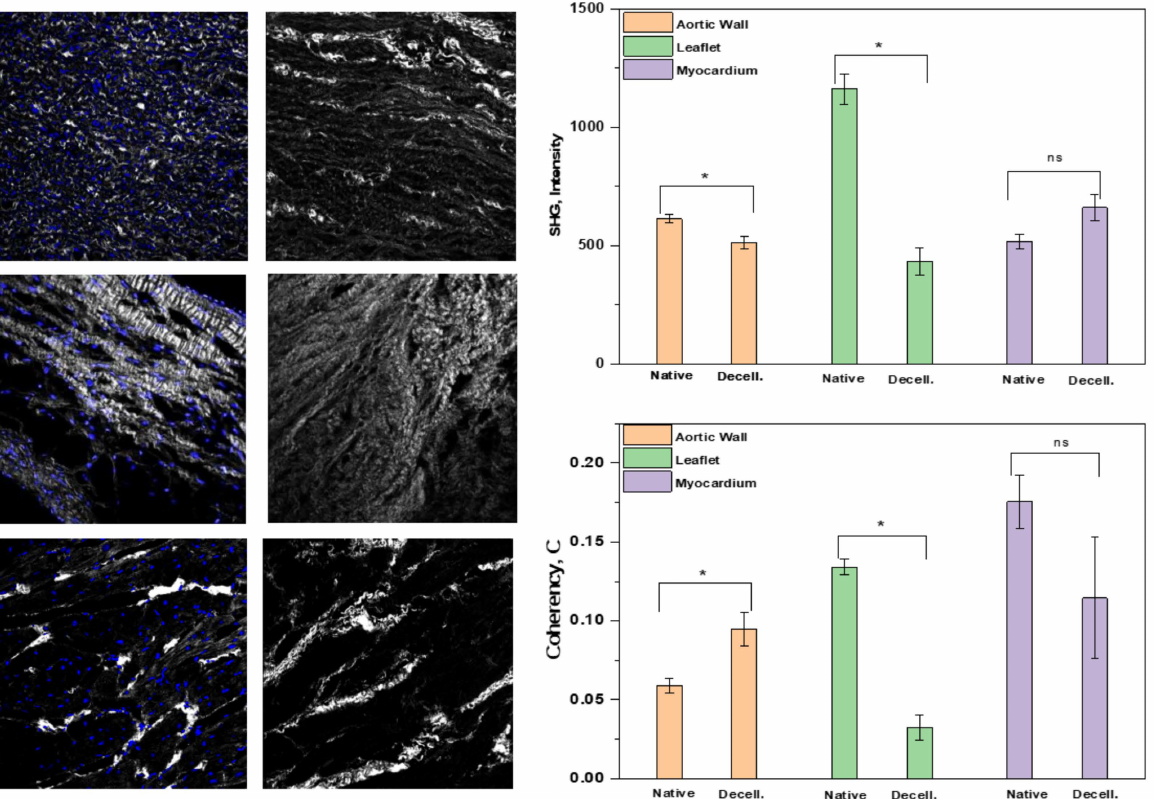
Figure 6. Pictures obtained by means of two photon microscope from native and decellularized aortic wall, leaflets and myocardium (ns = non significant, * denoted significance of difference between values of native and decellularized